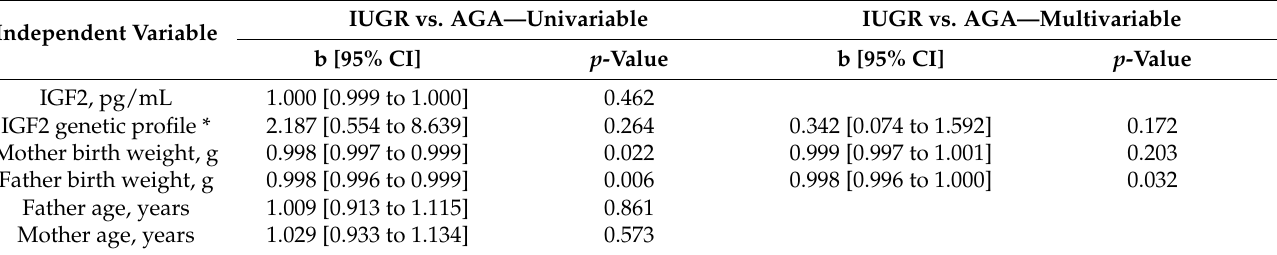
Table 3. Univariate and multivariate logistic regression